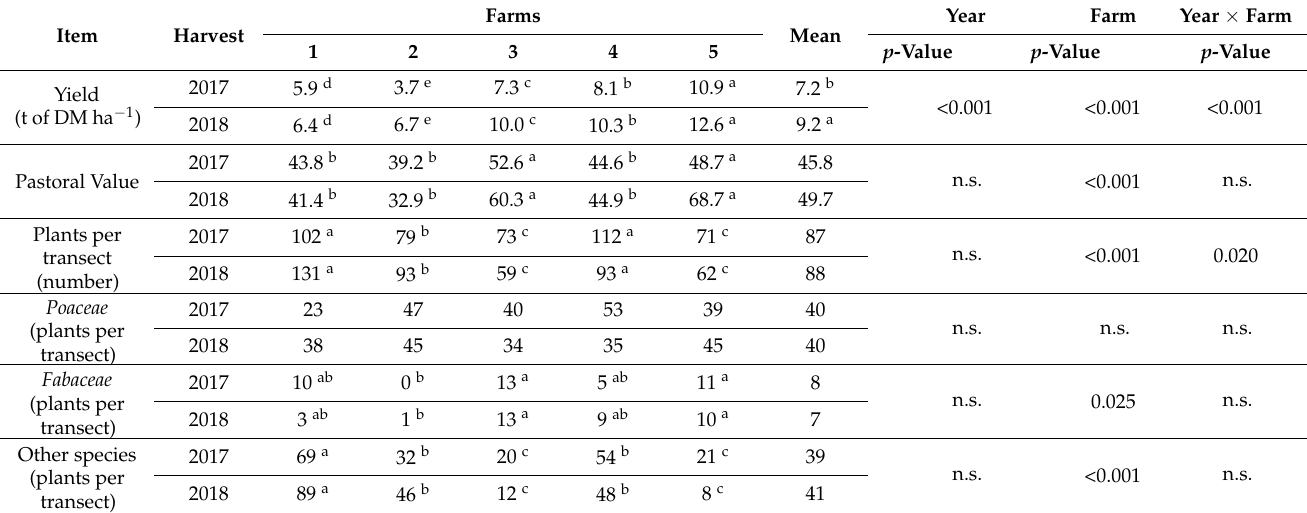
Table 1. Yield, Pastoral Value, and Dry Matter content of different